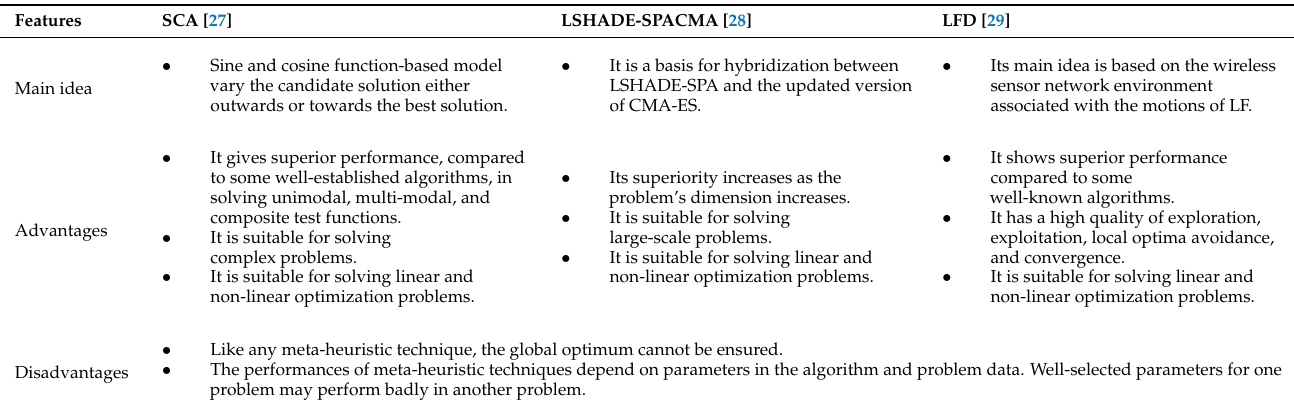
Table 1. Comparative analysis of SCA, LSHADE-SPACMA, and